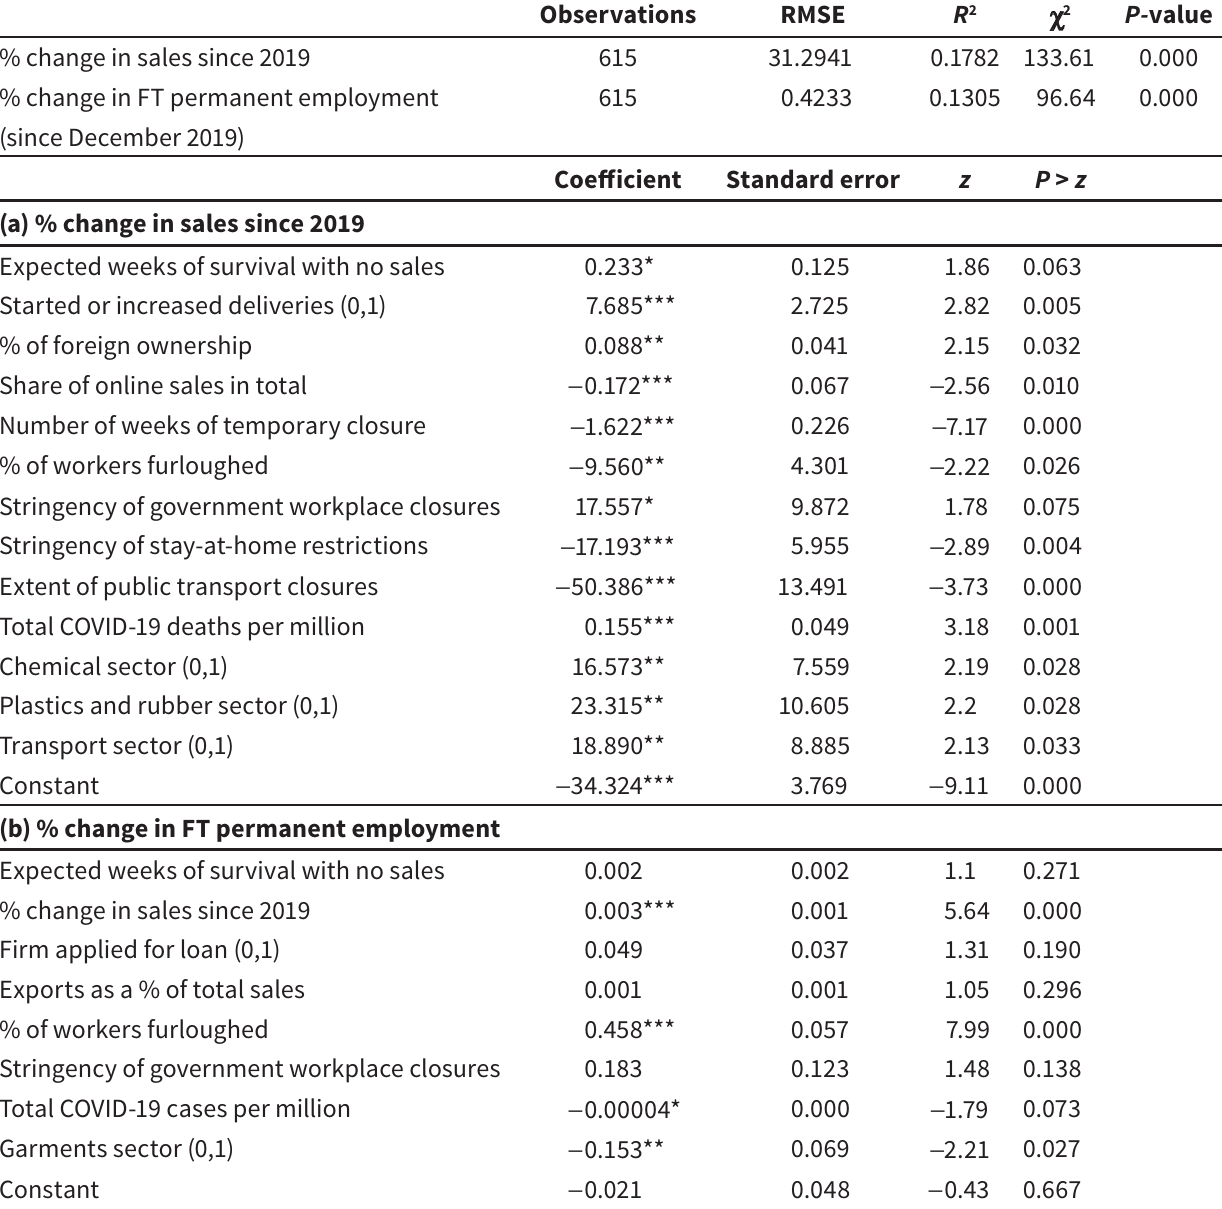
SURE estimation for changes in sales and employment